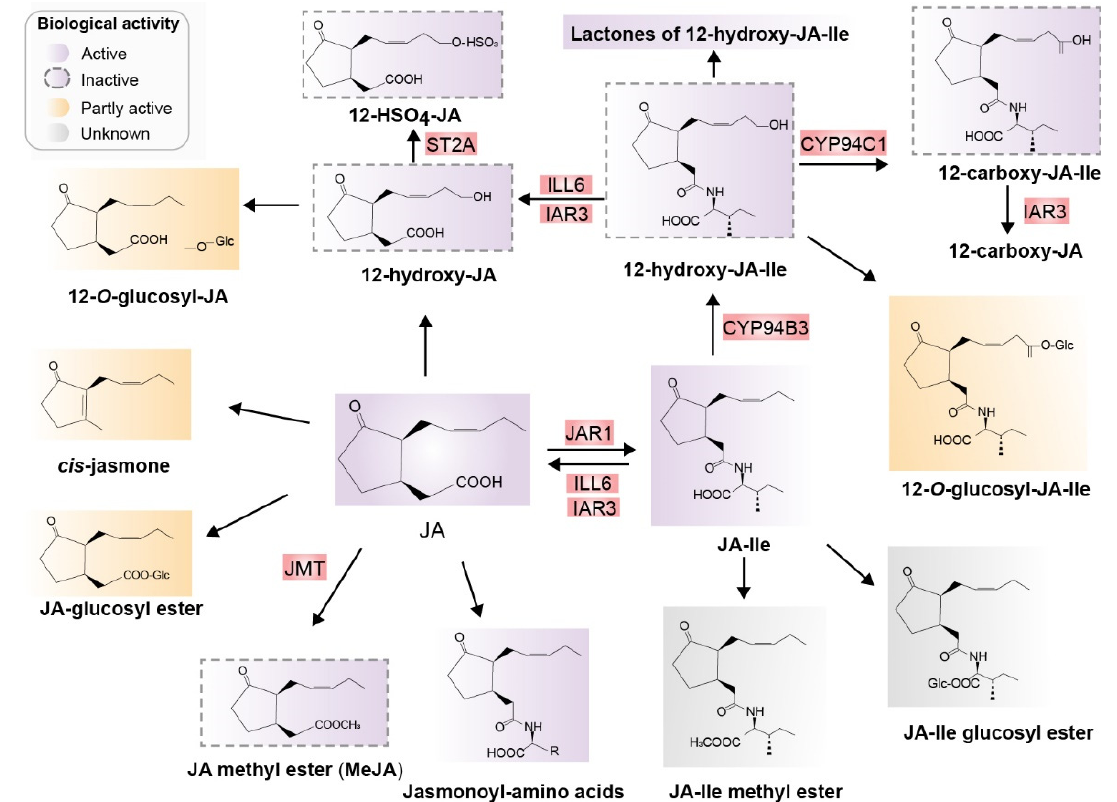
Figure 3. Major jasmonates arising from the metabolic conversion of JA. JA can be methylated to form JA-Me (MeJA) or JA glucosyl ester, decarboxylated to cis-jasmone, or hydroxylated to 12-OH-JA. 12-OH-JA can be sulfated and O-glucosylated, and conjugated with amino acids, preferring isoleucine, which results in JA-Ile. JA-Ile is methylated to JA-Me-Ile. Moreover, 12-hydroxylation of JA-Ile, carboxylation of 12-OH-JA-Ile, O-glucosylation of JA-Ile, and JA-Ile glucosyl ester formation are also possible. Known enzymes involved in these transformations are highlighted in red. Biologically active compounds are in purple and inactive compounds are indicated with dotted outlines in purple. Partially active compounds are shown in yellow, and unknown compounds in gray. Abbreviations: JA, jasmonic acid; JA-Ile, jasmonyl isoleucine; JMT, JA methyltransferase; JAR1, jasmonoyl isoleucine synthetase; CYP94B3, JA-Ile-12-hydroxylase; CYP94C1, 12-OH-JA-Ile carboxylase; the amidohydrolases IAR3 and ILL6; JMT, JA methyltransferase; ST2A, 12-OH-JA sulfotransferase (Redrawn based on [30]).